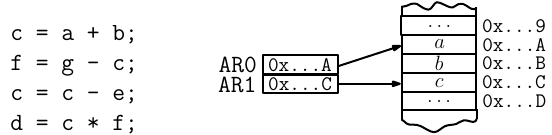
Figure 1 A sample code fragment and an illustration of ARs referencing memory locations of